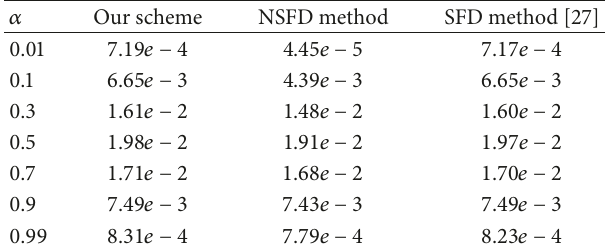
Table 8: Error norm 𝐿 ∞ for Example